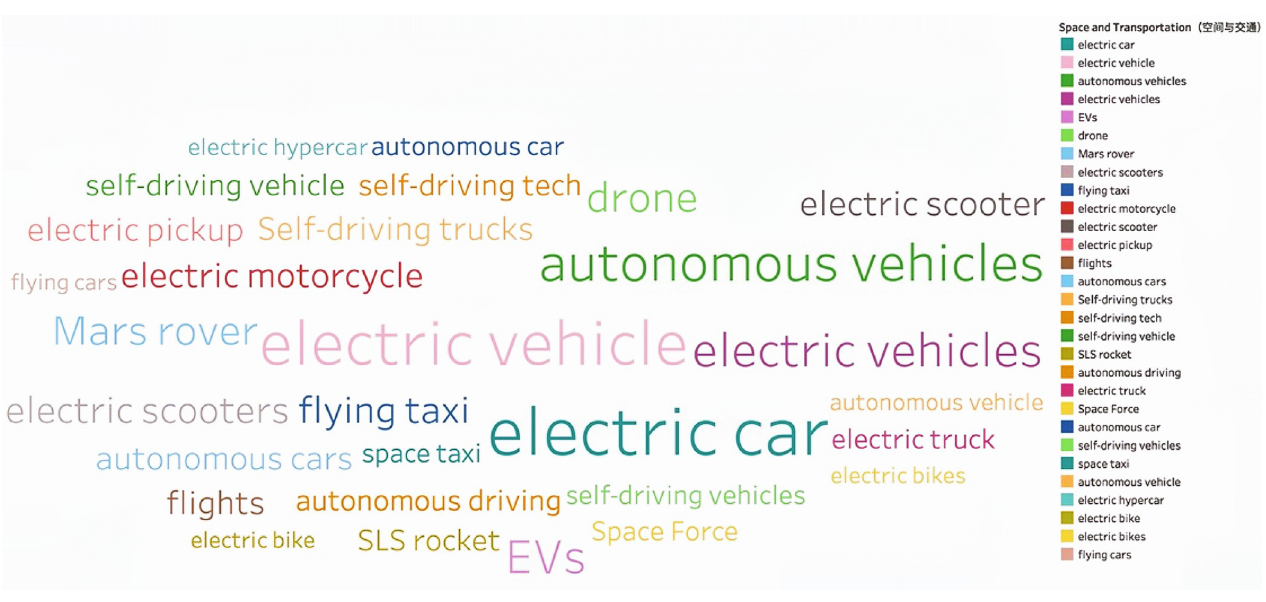
Fig 6. Word cloud diagram in the field of Space and